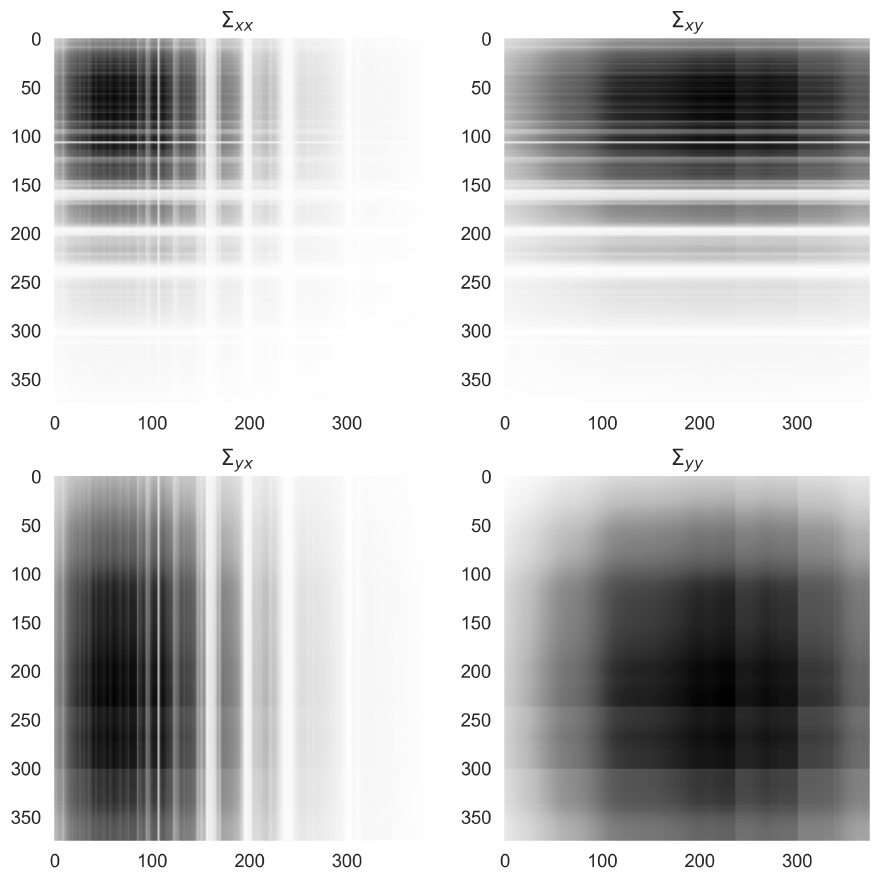
Figure 7. The covariance matrices computed from the radiance and reflectance data for the parameters for the conditional probability.